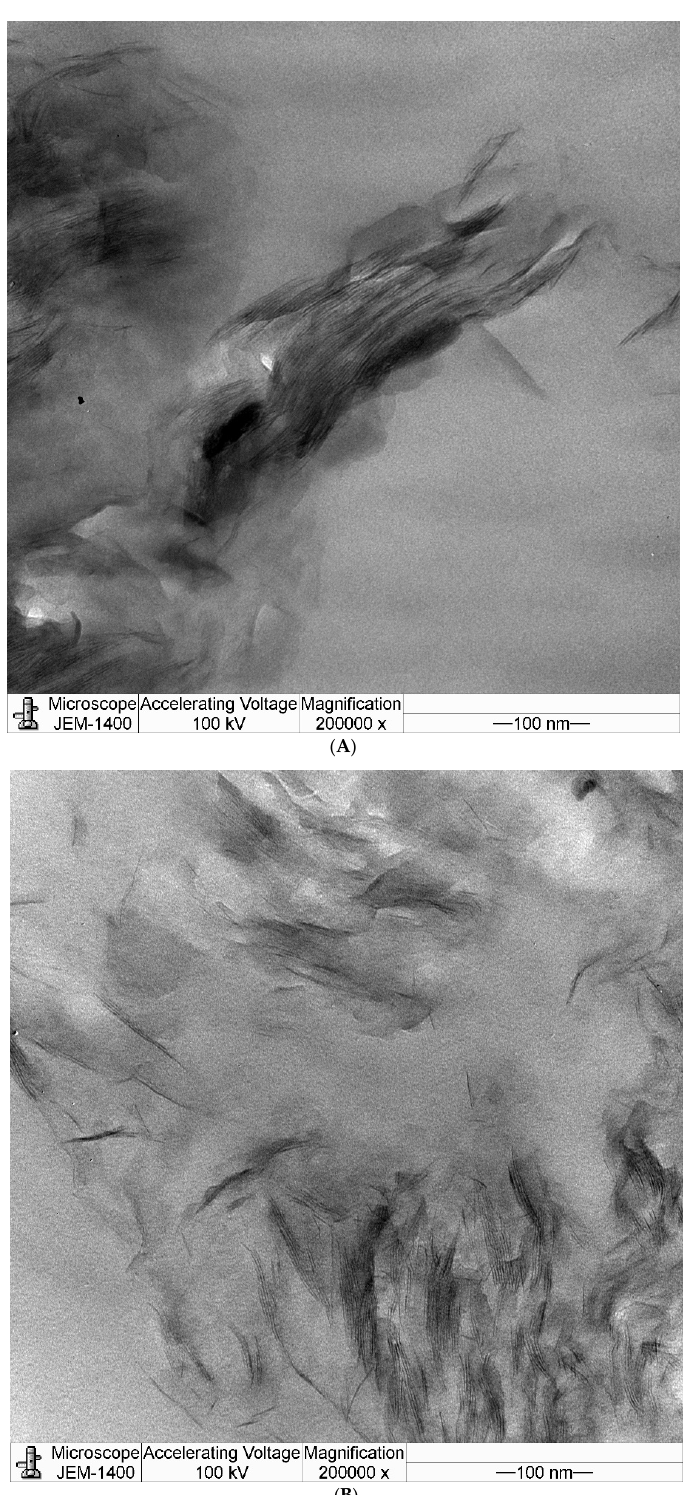
Figure 4. TEM images of ( A ) free 1% PCN at high magnification and ( B ) Free 3% PCN at high mag- nification.